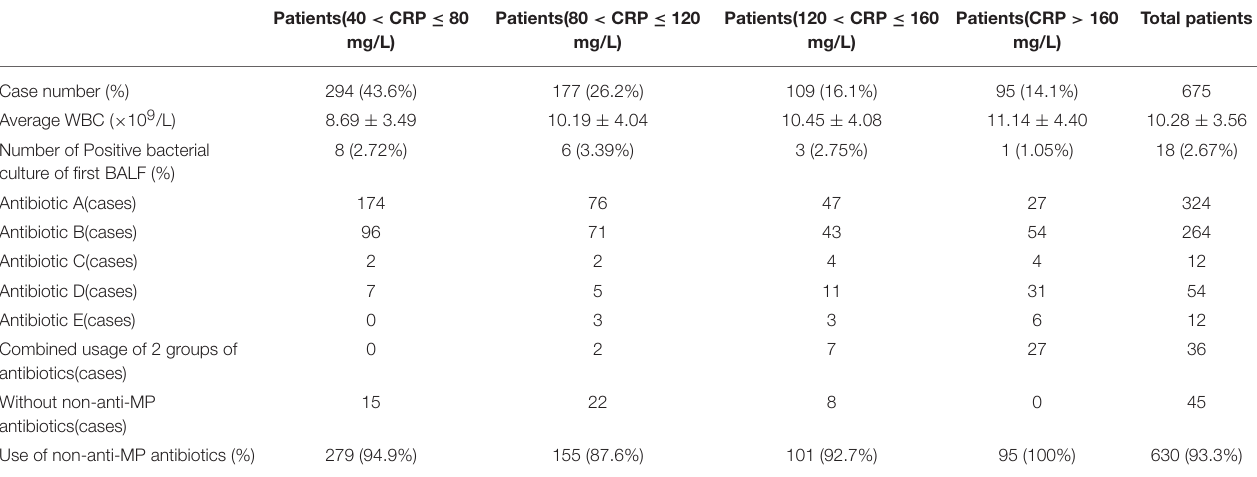
TABLE 2 | Laboratory examination, bacterial culture results of BALF, and Non-anti-MP antibiotic usage of RMPP